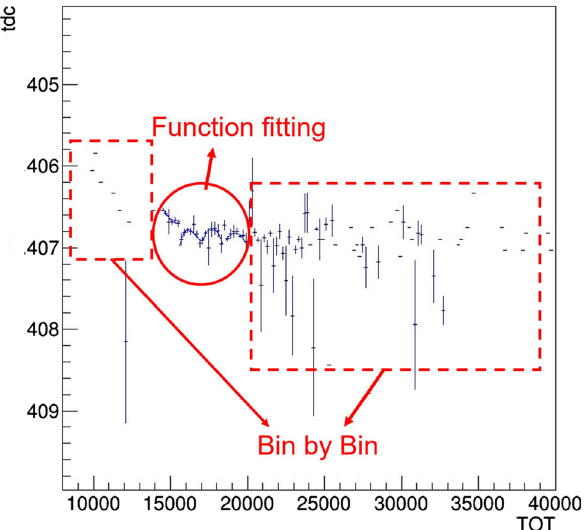
Fig. 10 MRPC timing and TOT plot divided into several parts.The circled part uses the function fitting and the rectangle parts use a bin- by-bin method to do slewing